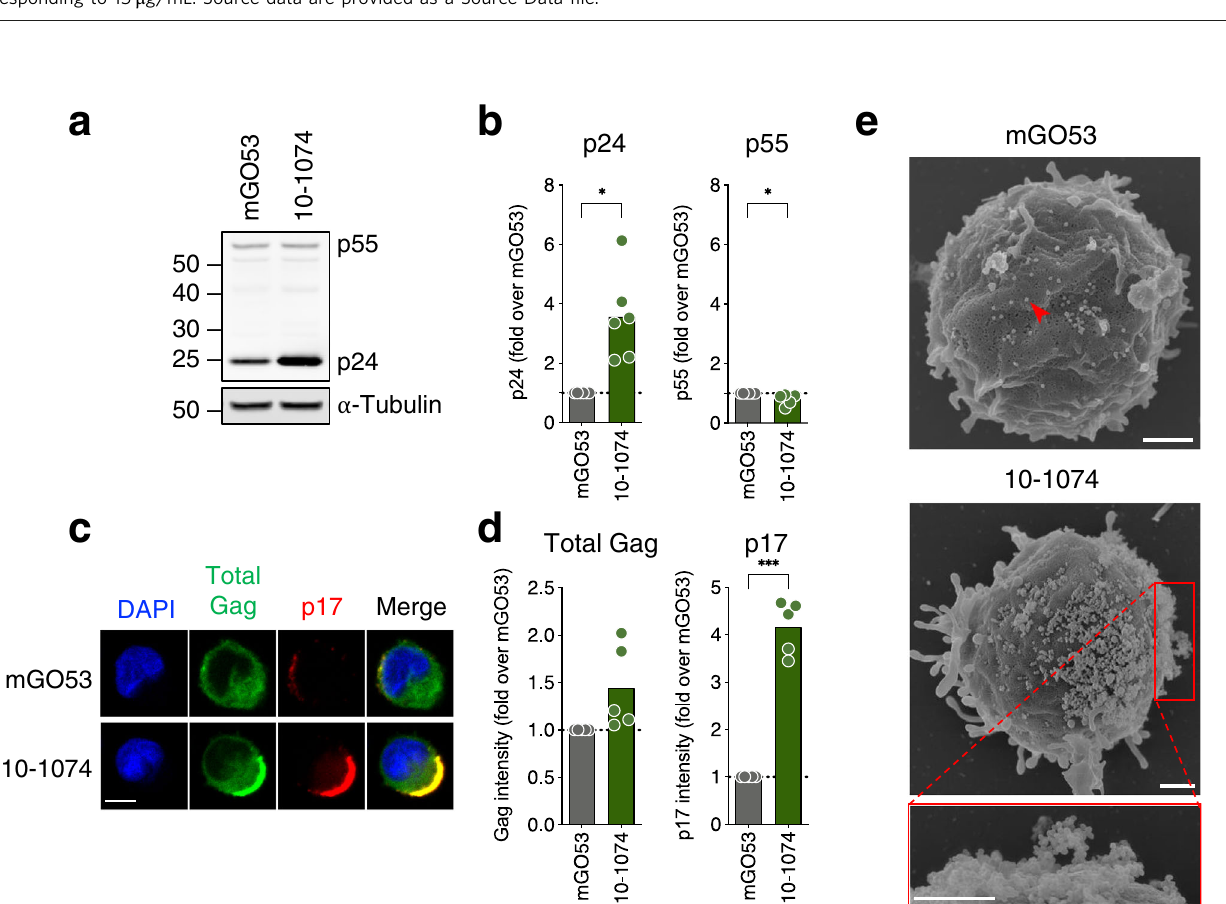
Fig. 1 bNAbs inhibit HIV-1 release. a Schematic of the experimental strategy. Primary CD4 T cells were infected with HIV-1 for 48 h, washed, and cultivated for 24 h with antibodies (anti-HIV-1 Env or isotype control; 100 nM, corresponding to 15 μ g/mL) in the presence of azidothymidine (AZT) and lamivudine (3TC) prior to subsequent analyses. b p24 levels in the supernatants of CD4 T cells infected with three strains of HIV-1 (AD8, CH058 or vKB18) and cultivated for 24 h with an isotype control (mGO53) or bNAbs (3BNC117 and 10 – 1074). p24 concentrations were measured by ELISA and normalized to the “ no antibody ” condition. Each dot represents a donor of CD4 T cells ( n = 6). * p = 0.0313 (two-tailed Wilcoxon test compared to mGO53). Bars represent the mean. c Representative fl ow cytometry histograms of Gag staining in non-infected (left) and infected (HIV-1 strain CH058 (CD4 − Gag + ); right) cells after 24 h of culture without antibody (No ab), with an isotype control (mGO53) or with a bNAb (10 – 1074). The dotted lines indicate the median fl uorescence intensity (MFI) of the “ No ab ” condition. d Cell-associated Gag levels of CD4 T cells infected with different strains of HIV- 1 and cultivated for 24 h with an isotype control or bNAbs. The MFI of staining was measured by fl ow cytometry and normalized to the “ no antibody ” condition. Each dot represents a donor of CD4 T cells ( n = 6). * p = 0.0313 (two-tailed Wilcoxon test compared to mGO53). Bars represent the mean. e Fold-change in the p24 levels in the supernatants (top) and the cell-associated Gag levels (middle) were measured in CD4 T cells infected with three strains of HIV-1 (AD8, CH058, and vKB18) and cultivated with non-neutralizing antibodies (nnAbs) or bNAbs targeting various epitopes of the envelope (CD4 binding site [CD4bs], V3 loop, V1/V2 loop, Membrane Proximal External Region [MPER] and gp120/gp41 interface). Levels of binding to infected cells for the same antibodies are also depicted (bottom). Data represent the mean of 6 donors of CD4 T cells. f Correlation between the fold-change in cell- associated Gag, the fold-change in supernatant p24 levels and antibody binding to infected cells. Each dot represents a different antibody ( n = 18). Mean values of six donors of CD4 T cells are depicted. Data from cells infected with three different viral strains are represented with different colors. A two-tailed Spearman correlation test was performed, and the correlation r and p -value are indicated. Antibodies were tested at a concentration of 100 nM, corresponding to 15 μ g/mL. Source data are provided as a Source Data fi le.